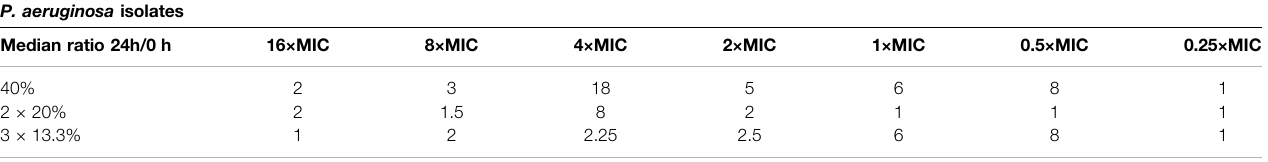
TABLE 2 | The median ratios of the minimal inhibitory concentration (MIC) from 24 to 0 h are depicted for P. aeruginosa isolates for all three regimens and all tested concentrations. A ratio at 1 or below indicates no change of the MIC. Ratios above 2 indicate an emergence of resistance. P. aeruginosa isolates